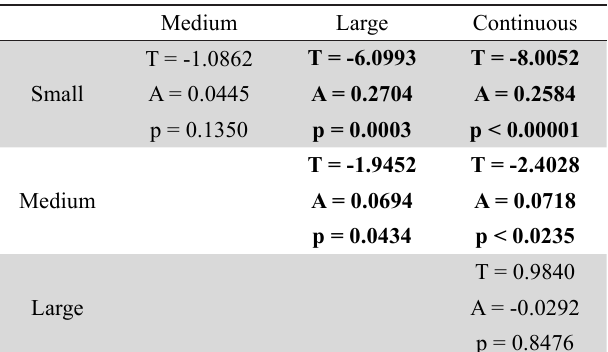
Table 1 . Pairwise comparison of plants life form community. T = variation between groups, A = intra-group variation, p = statistical significance. Significant p-values are in bold.